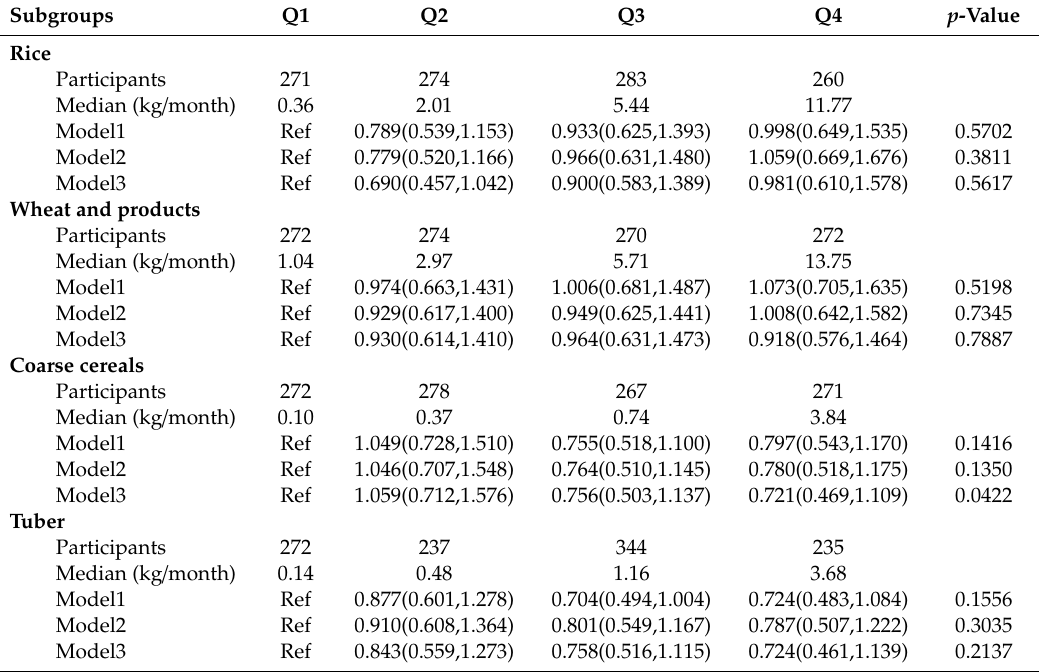
Table 5. The association between cereal subtype intakes and risk of metabolic syndrome among adults in northern